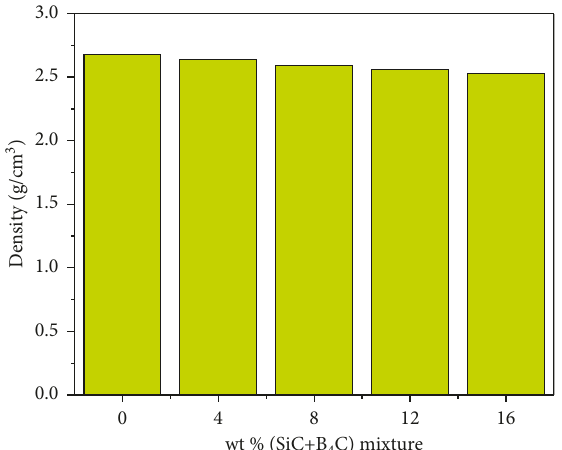
Figure 10: Density with variant weight percentage of (SiC +B mixture.